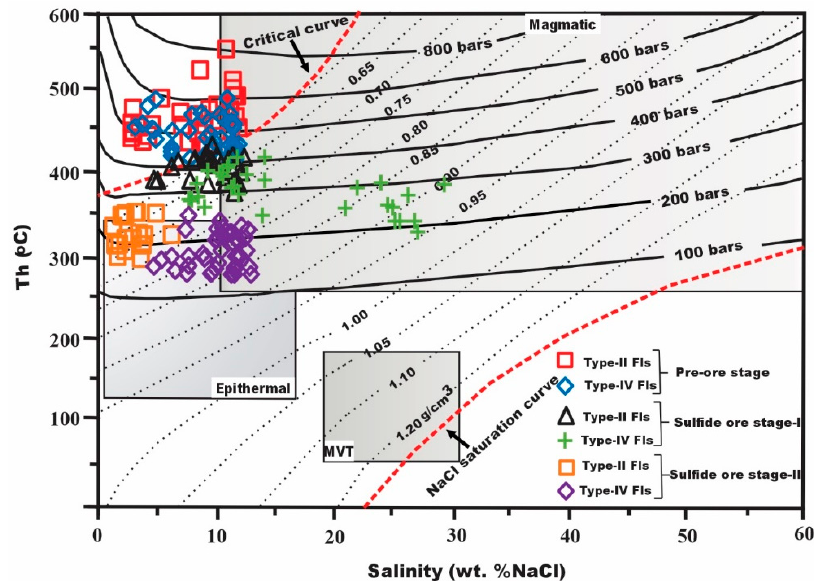
Figure 13. Typical ranges of fluid inclusions in magmatic, epithermal, and MVT deposits worldwide and pressure estimation diagram, (modified after [72,75]), for the pre-ore and sulfide-ore stage fluid inclusions of the Kargah Cu-Pb polymetallic deposit.